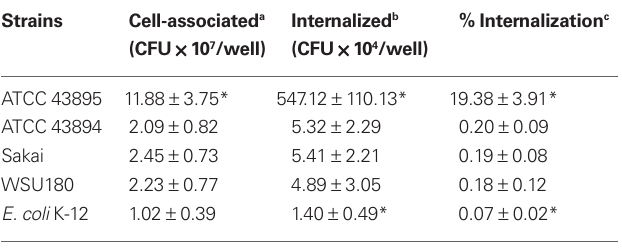
Table 3 | internalization of E. coli O157:H7 and K-12 by primary bovine rectal epithelial cells ( n = 3).